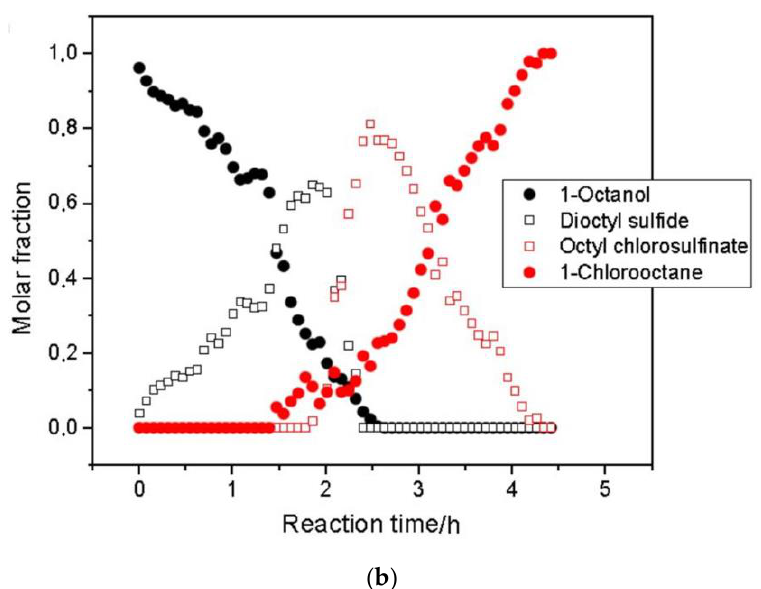
Figure 6. ( a ) 1 H NMR (60 MHz) spectra reflecting the progress of 1-octanol chlorination to afford 1-chlorooctane and ( b ) the related quantitative data. Adapted with permission from [73], Wiley, 2020.